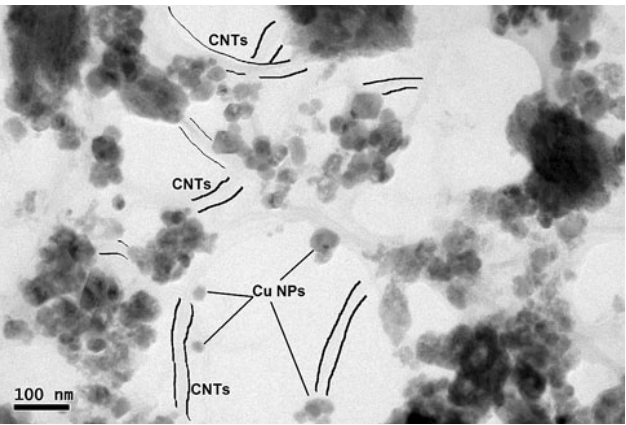
Figure 4. HRTEM micrograph of as-consolidated CNT reinforced Cu matrix